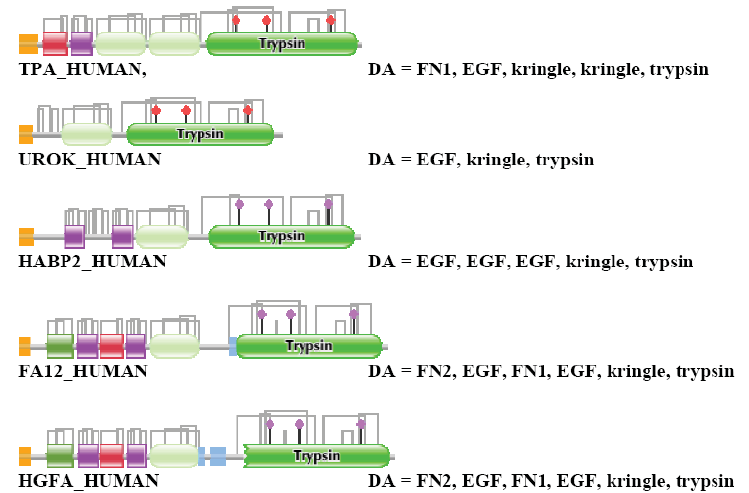
Figure S1. Comparison of the domain architectures of TPA_HUMAN and its closest human paralogs.